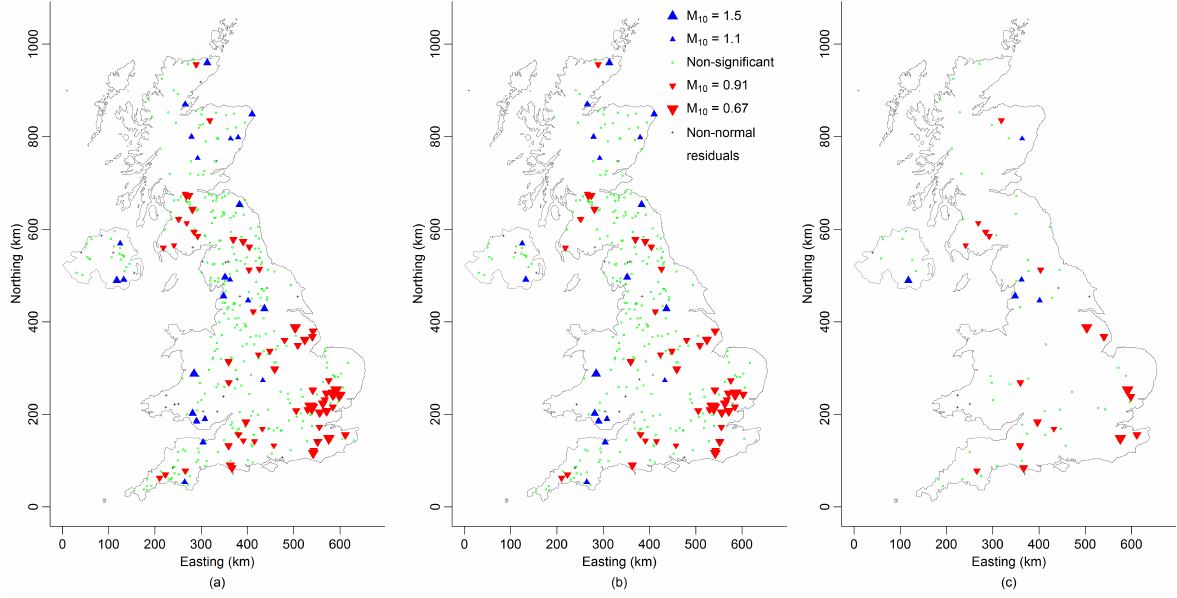
Fig. 11. Estimated decadal magnification factor M 10 for model (c) for all the available series (a) , for series with non-natural flow (b) and for series with near-natural flow (c) – summer maxima